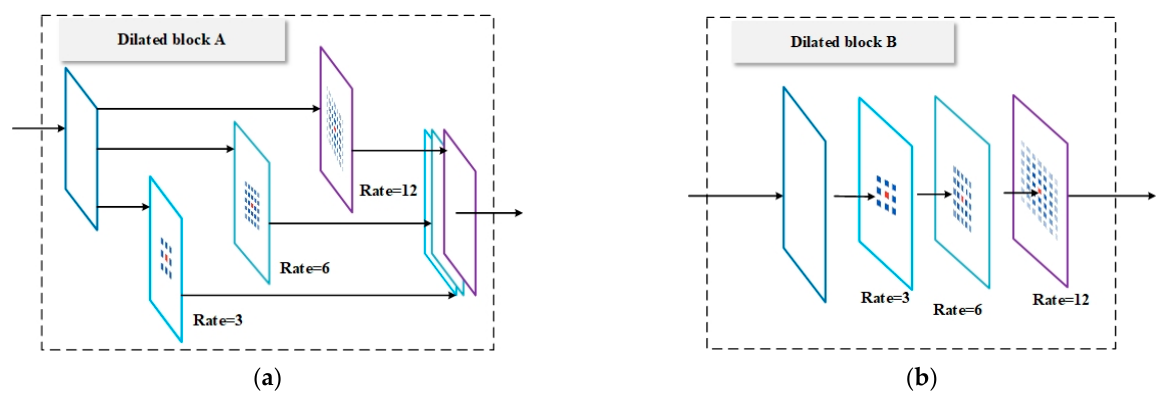
Figure 5. Illustration of other structures of Dilated block: ( a ) series connection; ( b ) parallel connection. The dilated convolution of residual connections can be described as a recursive formulation.